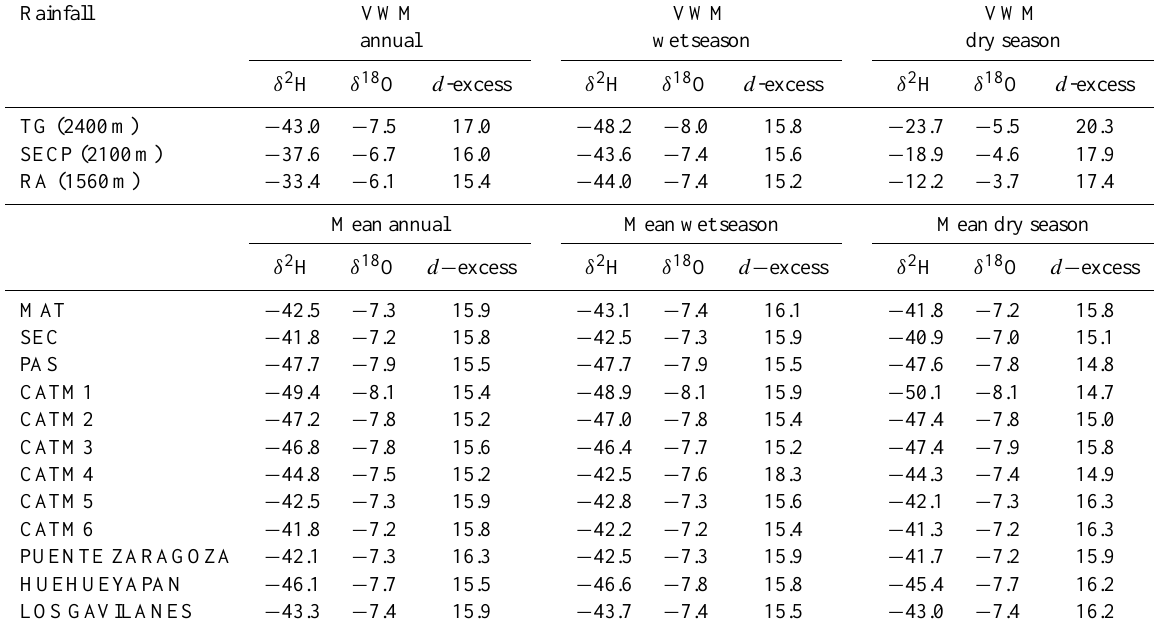
Table 2. Annual, and wet and dry season means of the isotopic composition of rainfall (three sites) and stream water (12 sampling locations) plus corresponding values of d -excess, as calculated from 2 years of data (April 2008–May 2010). Rainfall